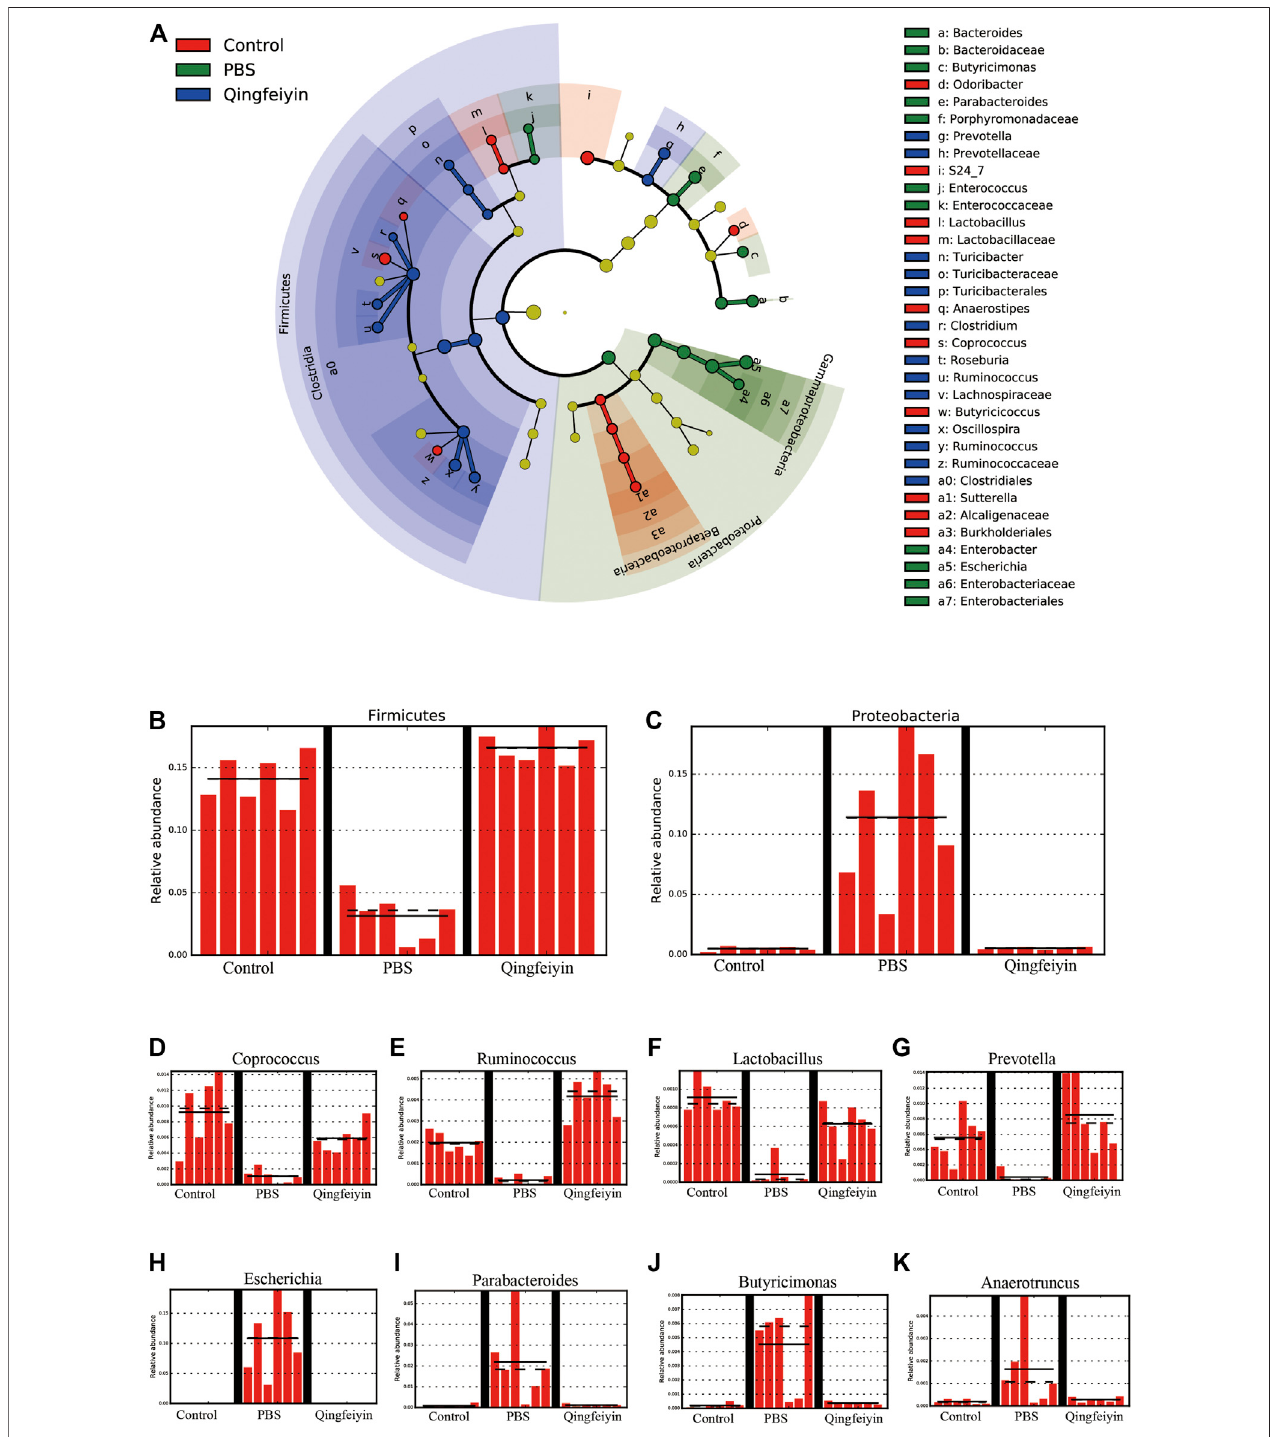
FIGURE7| LEfSeanalysisofcecumcontent. (A) ,cladogramgraph, (B,C) arehistogramplotsofthephylumofFirmicutesandProteobacteria. (D – K) representthe genus of Coprococcus , Ruminococcus , Lactobacillus , Prevotella , Escherichia , Parabacteroides , Butyricimonas , and Anacrotruncus, respectively.